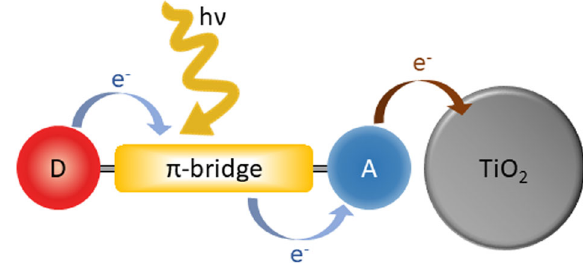
Fig. 3 Illustration of D- π -A architecture with TiO 2